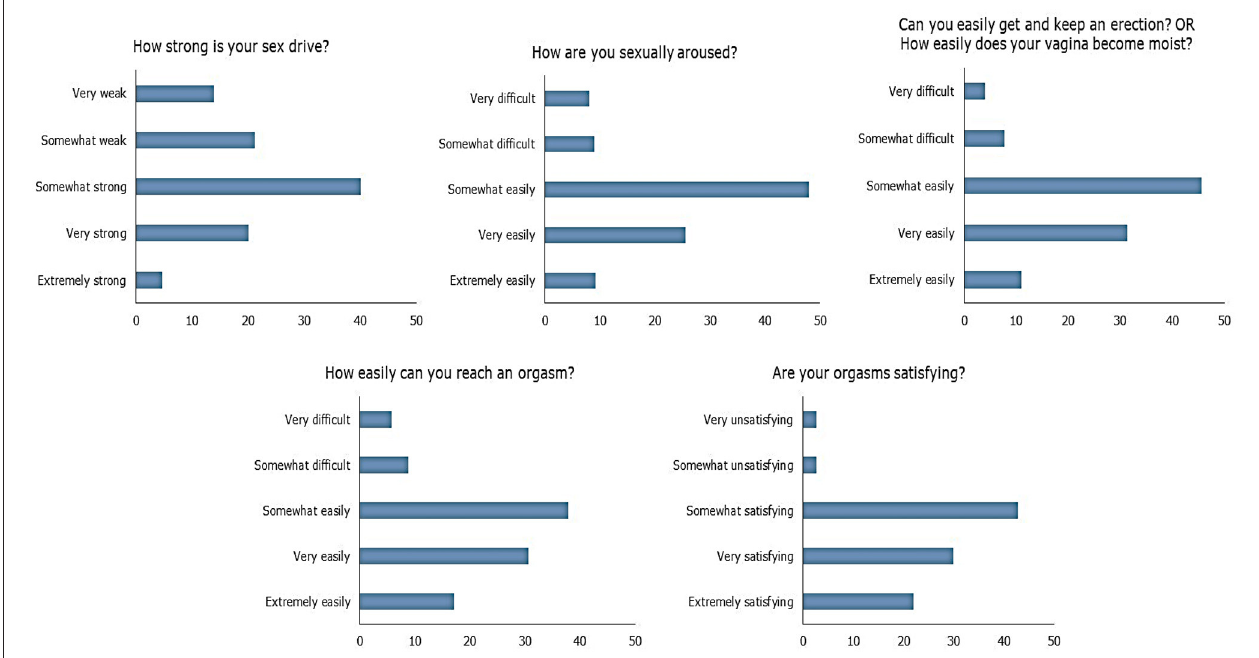
FIGURE 1 | Summary of responses to the items in Arizona Sexual Experience Scale (ASEX).